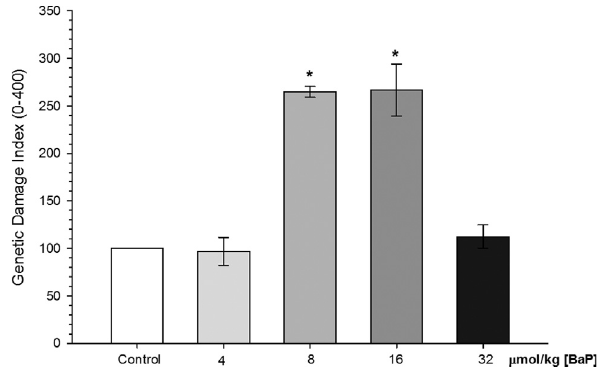
Figure 5 - Relative expression of gene hif-1 (cid:2) gene in C. macropomum af- ter 96 h of injection of different concentrations of B[a]P. * Indicates signif- icant difference in comparison to control group (corn oil) (p < 0.05). Kruskal-Wallis test was